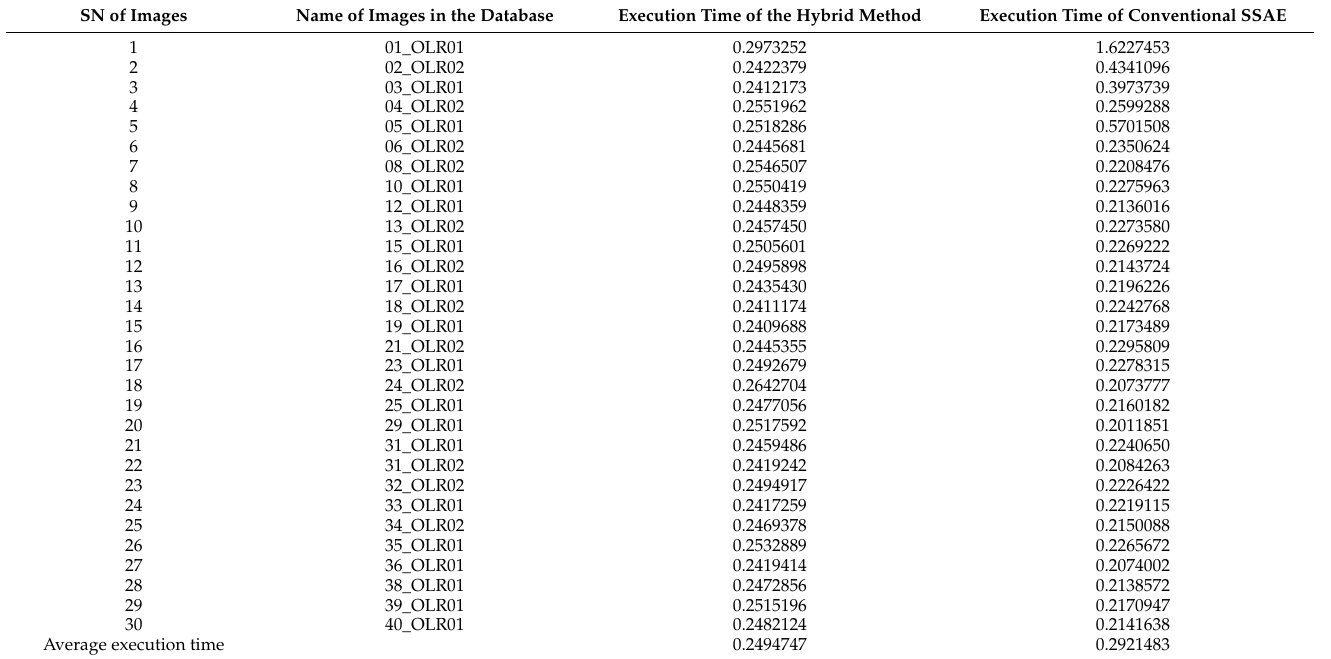
Figure 12. The learning curve for the proposed SSAE deep neural network for the Extended Yale-B database. Table 3. Execution time computed for the OLR database.